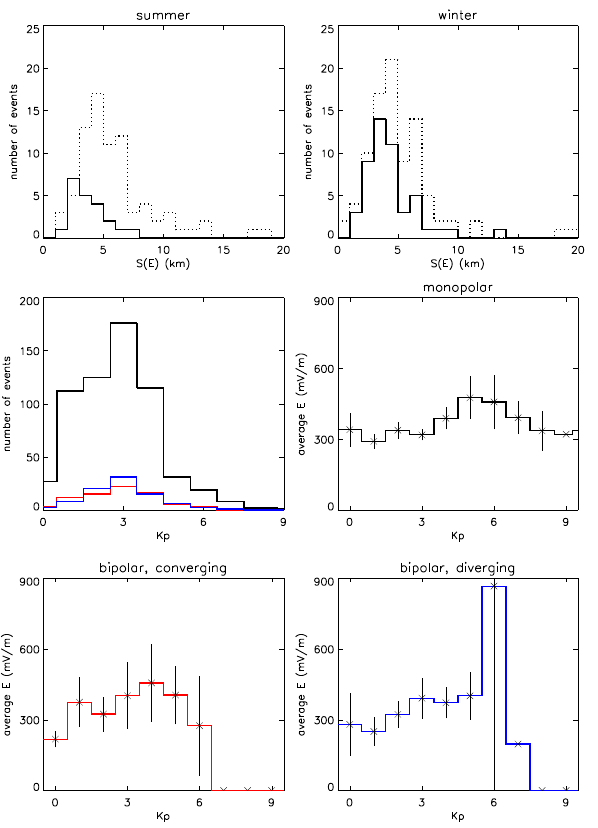
Fig. 6. Average potential V (upper panel) and average electric field magnitude (middle panel) for bins in S(E) together with number of events vs. electric field magnitude (bottom panel). Only monopolar events. All values mapped to the ionosphere. A selection criterion in this study was an electric field magnitude of at least 150mV/m. The error bars indicate the 95.5% confidence